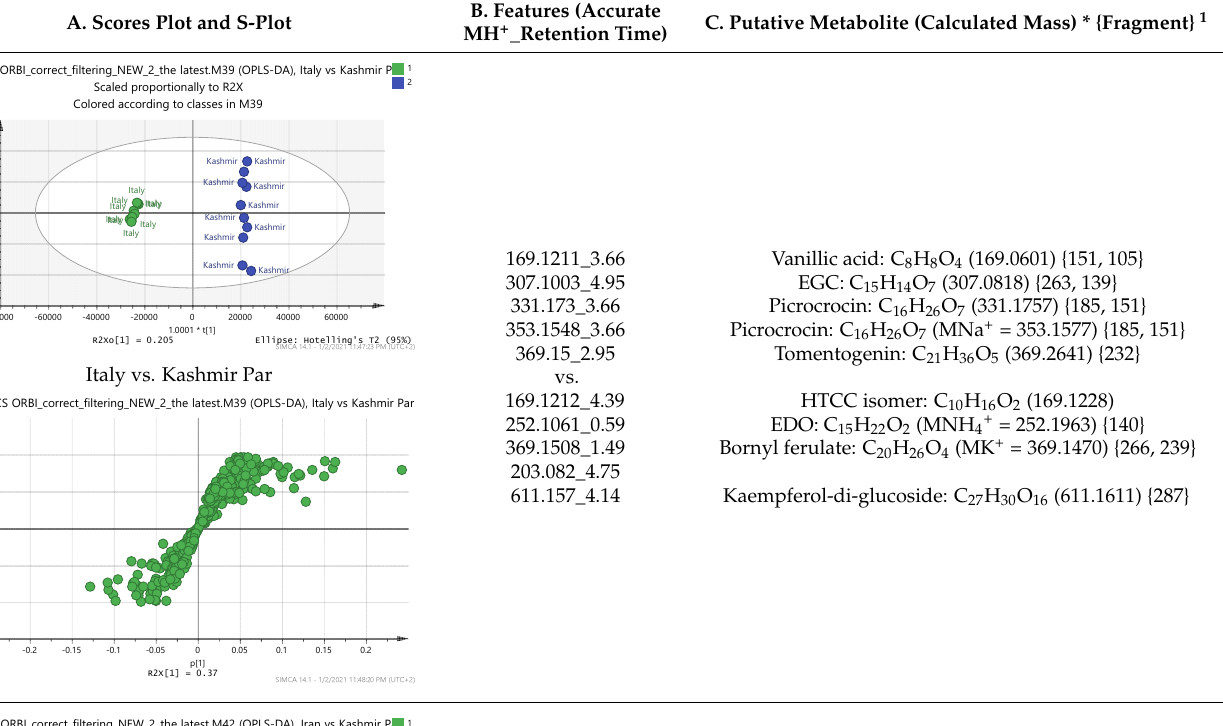
Table 1. Cont . C. Putative Metabolite (Calculated Mass) * {Fragment} 1